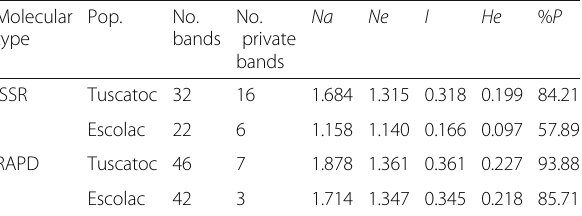
Table 2 Genetic variation statistics revealed through RAPD and ISSR markers among the B. hyrcana genotypes Molecular type